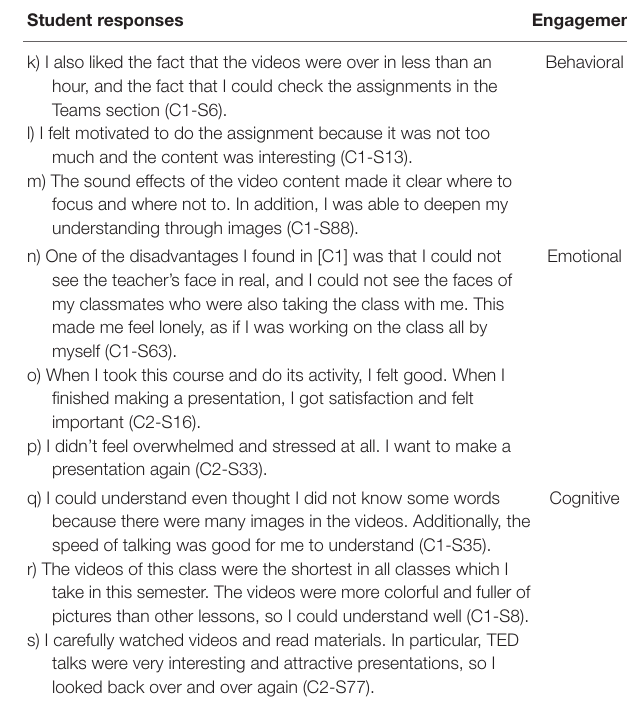
TABLE 3 | Student responses related to